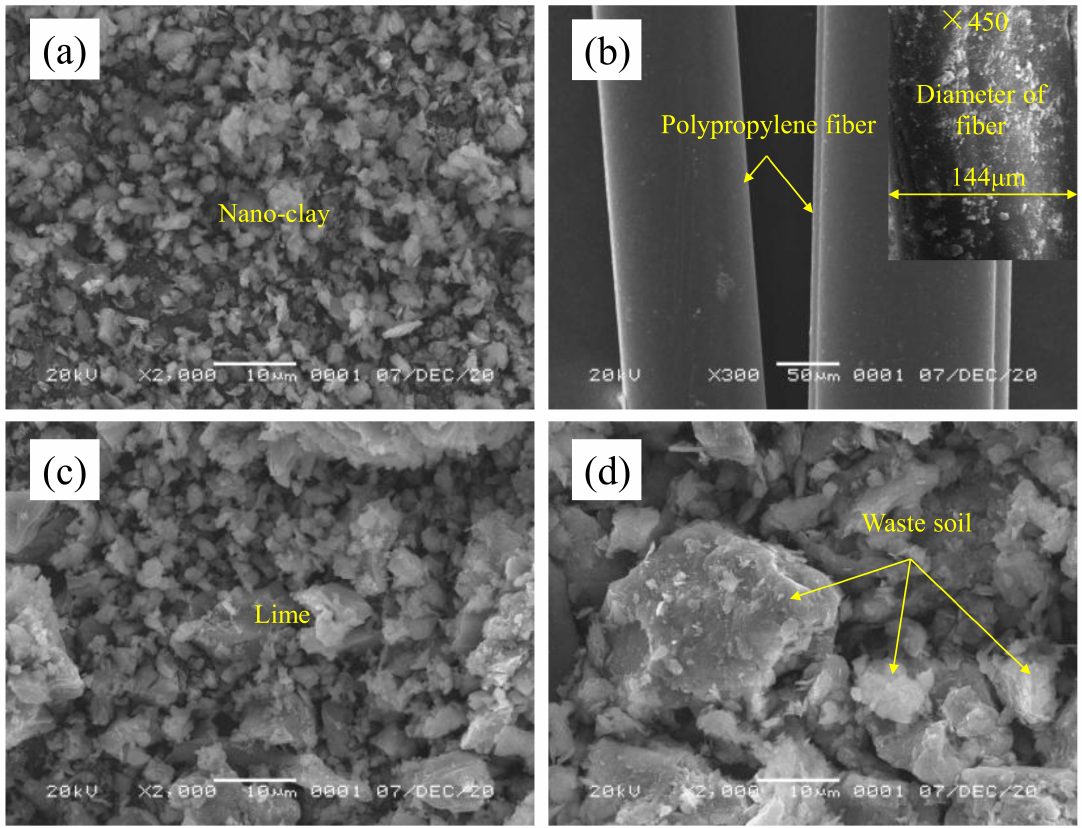
Figure 2. Test materials: ( a ) SEM image of Nano-clay; ( b ) SEM image of Polypropylene fiber; ( c ) SEM image of lime; and ( d ) soil.2.2 Sample making and